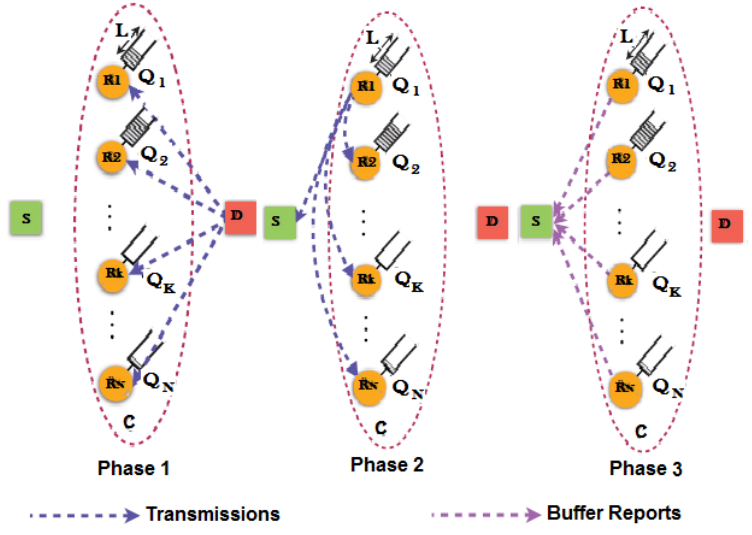
Figure 6. Three-phase CSI and buffer state exchange.